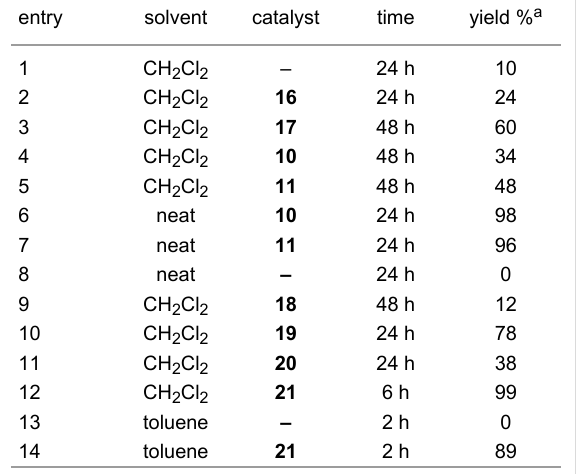
Table 2: Ring opening of epoxide 15 with aniline and 10 mol %